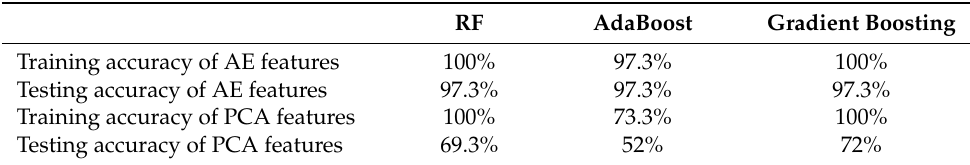
Table 1. Accuracies of the AE-based and PCA-based features in the three classifiers.